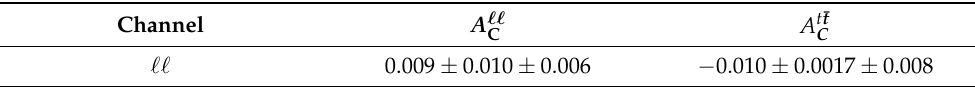
Table 2. Results for the lepton-based asymmetry A (cid:96)(cid:96) for detector, resolution, and acceptance effects. The values are presented with their statistical and systematic uncertainties